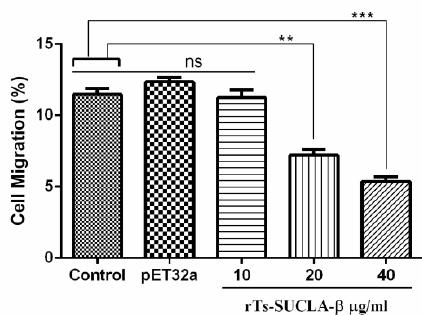
Figure 5. E ff ects of rTs-SUCLA- β on PBMCs migration. Cells were treated with PBS (control), purified pET-32a protein and serial concentrations of rTs-SUCLA- β . Then the random migration was determined. Statistically di ff erences between standard error mean of three independent experiments ( n = 5) were calculated using a one way ANOVA and marked with ** when p < 0.01 and *** when p < 0.001.